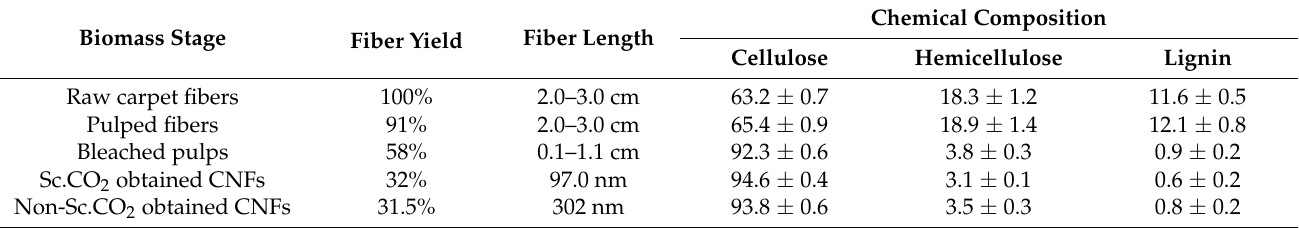
Table 2. The fiber yield, fiber length, and chemical analysis after each stage of CNF